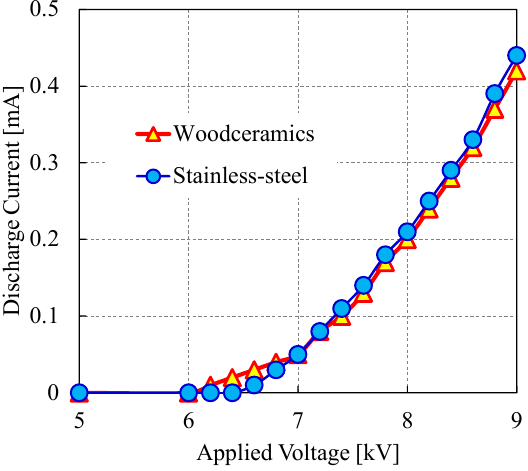
Figure 11. Corona discharge current as a function of the applied voltage for various electrodes. The discharge current characteristics of the two electrodes follow similar trends.